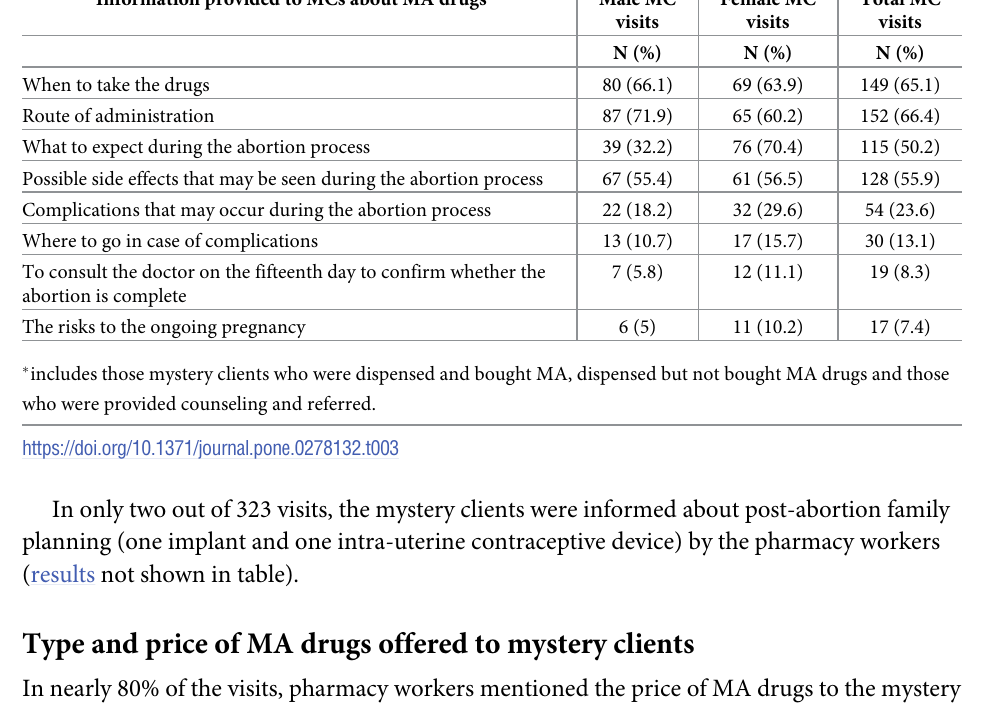
Table 3. Information provided to mystery clients about MA drugs by pharmacy workers (N = 229) (multiple choice). Information provided to MCs about MA drugs �